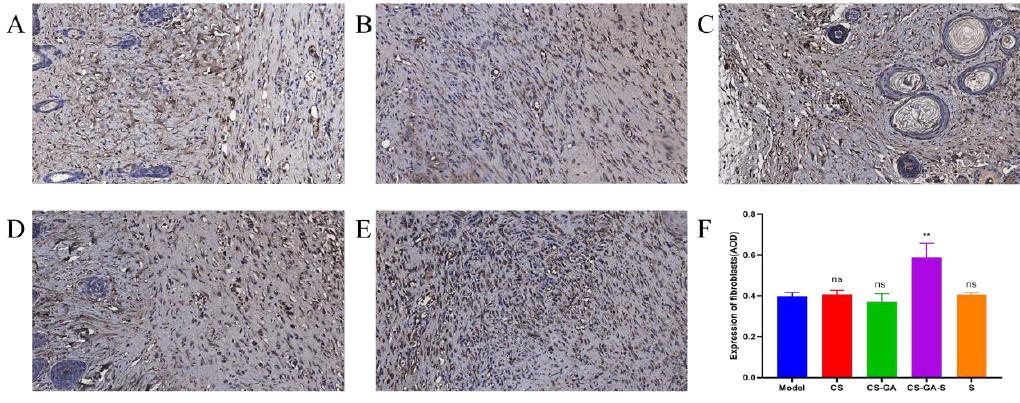
Figure 13. Representative IHC images of regenerated wound tissues with anti-c-kit. ( A ) Model group, ( B ) CS group, ( C ) hydrogel group, ( D ) scolopin2 group, and ( E ) CS-GA-S group ( × 1000 ) .